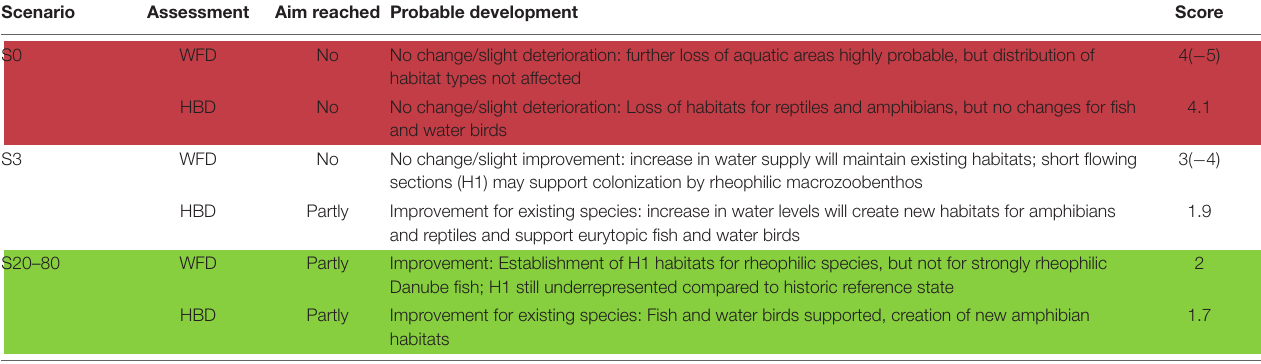
TABLE 4 | Combined evaluation of the different scenarios for the floodplain Lobau based on the WFD and HBDs assessments of the floodplain area located in Vienna.